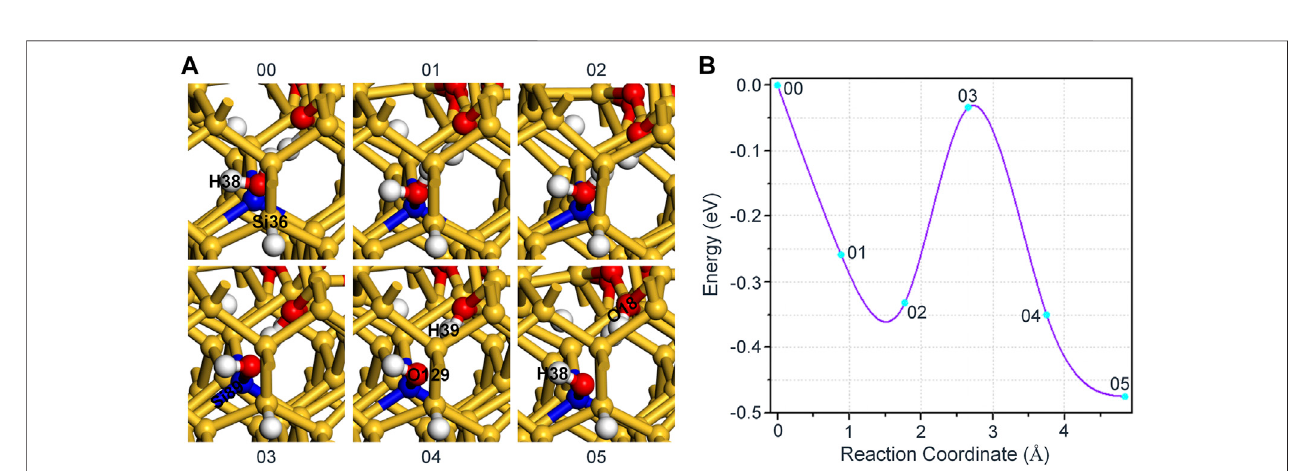
FIGURE 3 | (A) The schematic diagram of the reaction between P b0 defect and H 2 O. The orientation of the dangling bond (Si36) is changed from [ 111 ] to [ 111 ] , thus expanding the space where H 2 O exists. (B) The variation of the energy with different reaction coordinates for the reaction of H 2 O and P b0 defect.